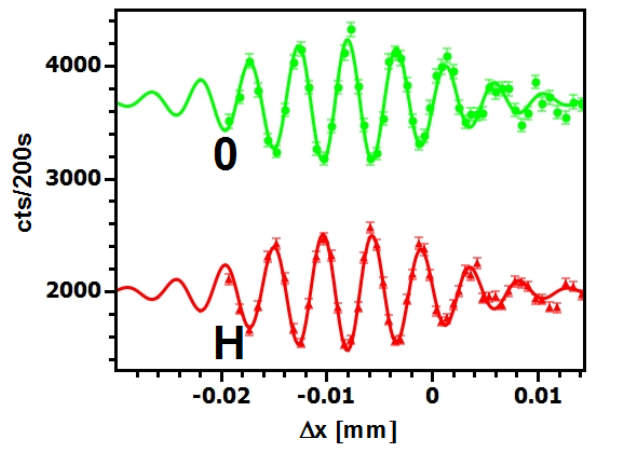
Figure 9. Intensity oscillations measured at the instrument D22 of the ILL with the d-PMMA grating-interferometer for CN [66]. ∆ x is the path-length difference between left and right interferometer path induced by stepwise rotation of a sapphire phase-shifter slab in the